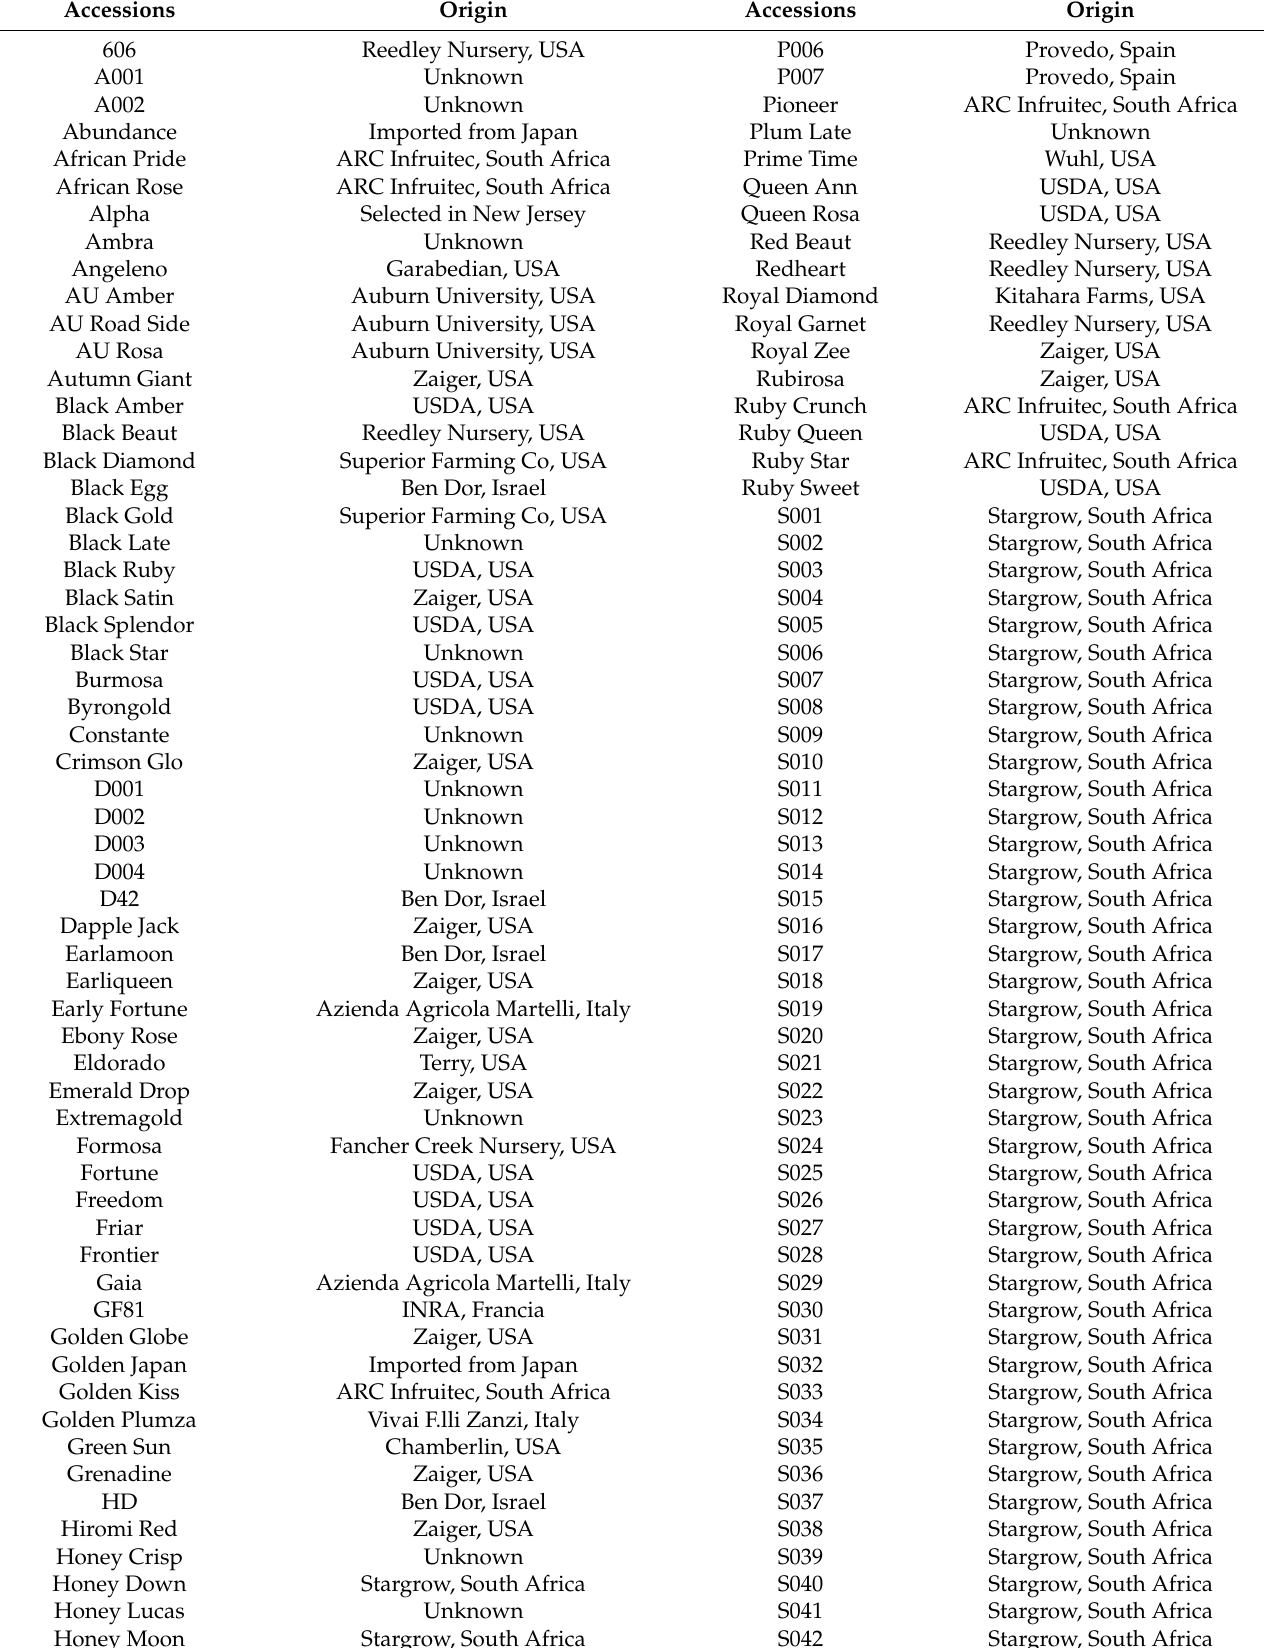
Table 1. Japanese plum-type accessions analyzed in this